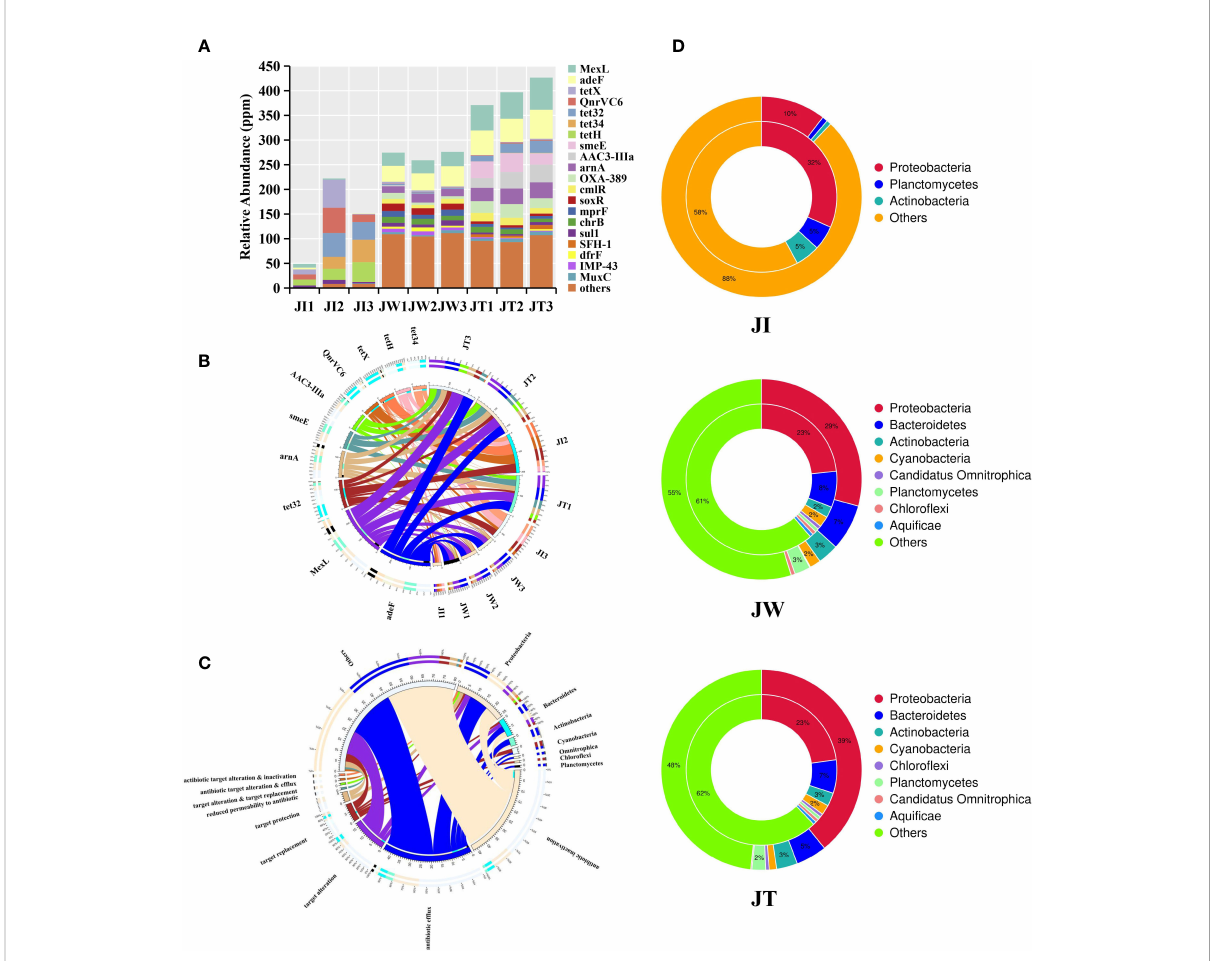
FIGURE 10 Results of resistance gene annotation in intestinal, water, and ef fl uent samples in “ Fishery-PV Integration ” ponds. (A) Indicates the relative abundance of all the genes in each ARG sample (in ppm, the result of magnifying the original relative abundance data 10 6 times). (B) The ten most abundant ARGs are plotted on a circle diagram. The circle diagram is divided into two parts: ARG information on the left and sample information on the right. Different colours of the inner ring represent different samples and ARGs, and their scale represents their relative abundance in ppm. (C) The circle diagram consists of two parts. The species information at the phylum level is on the right side, and the left shows resistance mechanism information. The different colours in the inner circle indicate the resistance mechanisms of different species and resistances, and the scale represents the number of genes. The left side shows the sum of the number of resistance genes in the species that contain this type of resistance mechanism, and the right side shows the sum of the number of resistance genes contained in different resistance mechanisms. (D) Species identi fi cation analysis of ARGs in JI, JW, and JT samples. The inner circle represents the species distribution of ARGs, and the outer circle represents the species distribution of all genes in the